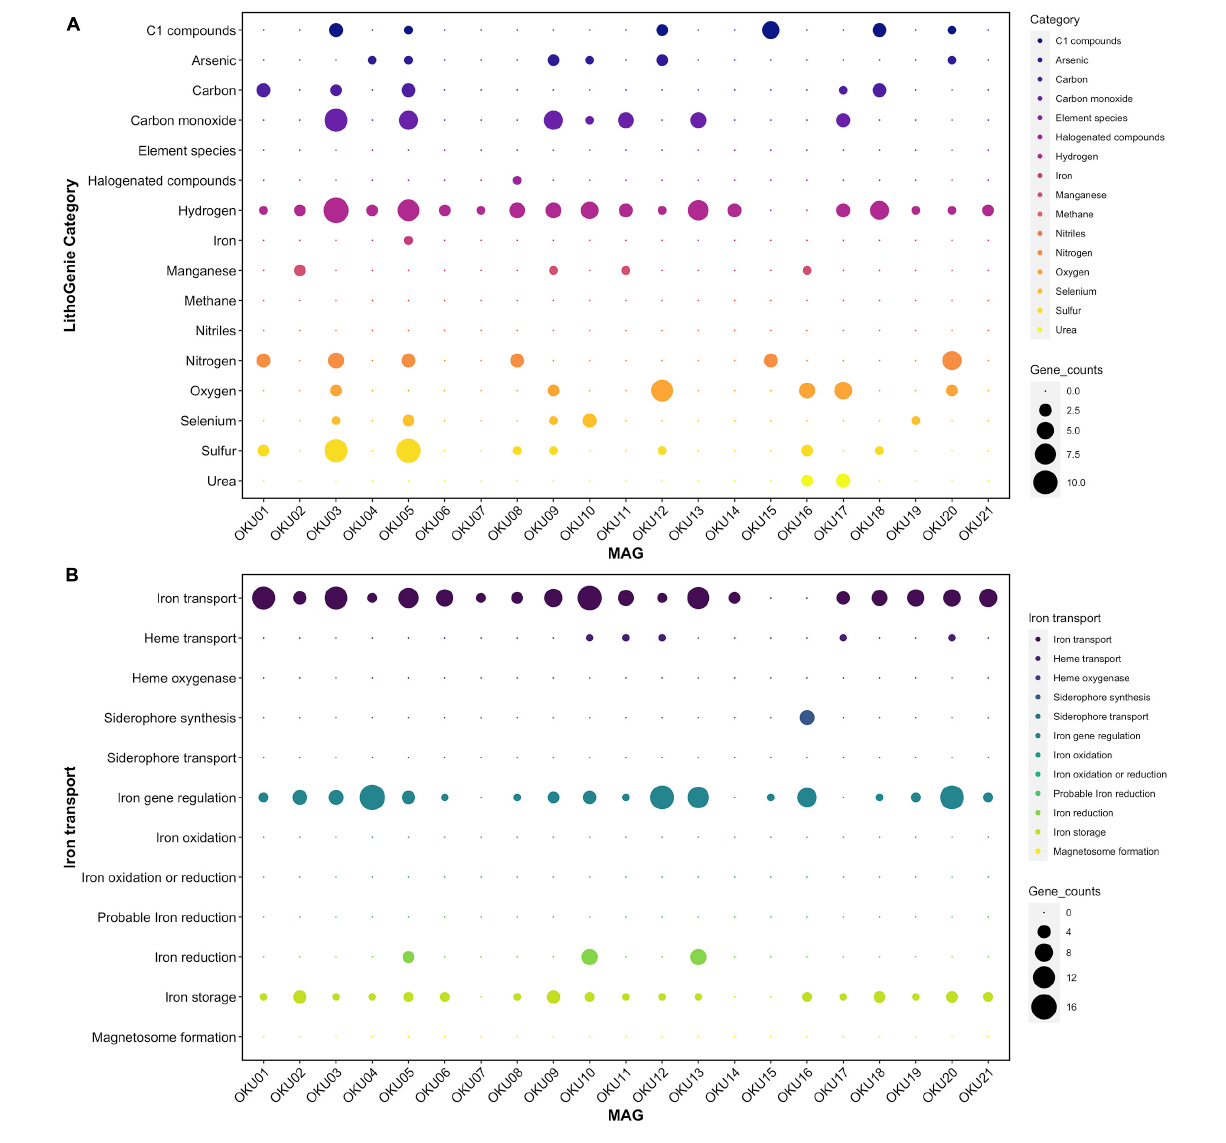
FIGURE 7 | Metabolic potential in different MAGs analyzed with LithoGenie (A) and FeGenie (B) . MAG contig open reading frames (ORFs) were first analyzed with Prodigal from contig nucleic acid sequences whereafter amino acid sequences were compared against LithoGenie and FeGenie HMM gene databases. Gene counts were calculated separately for each Genie